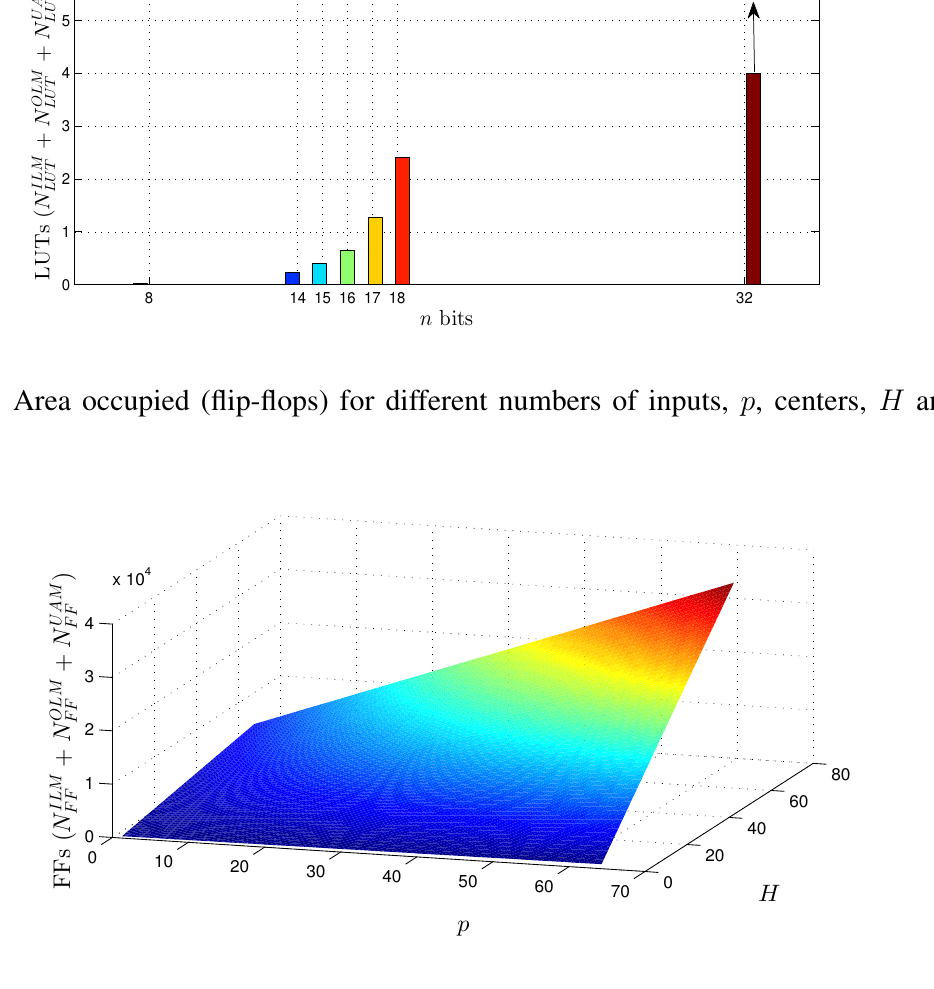
Figure 14. Area occupied (LUTs) for different numbers of inputs, p , centers, H and M = 1